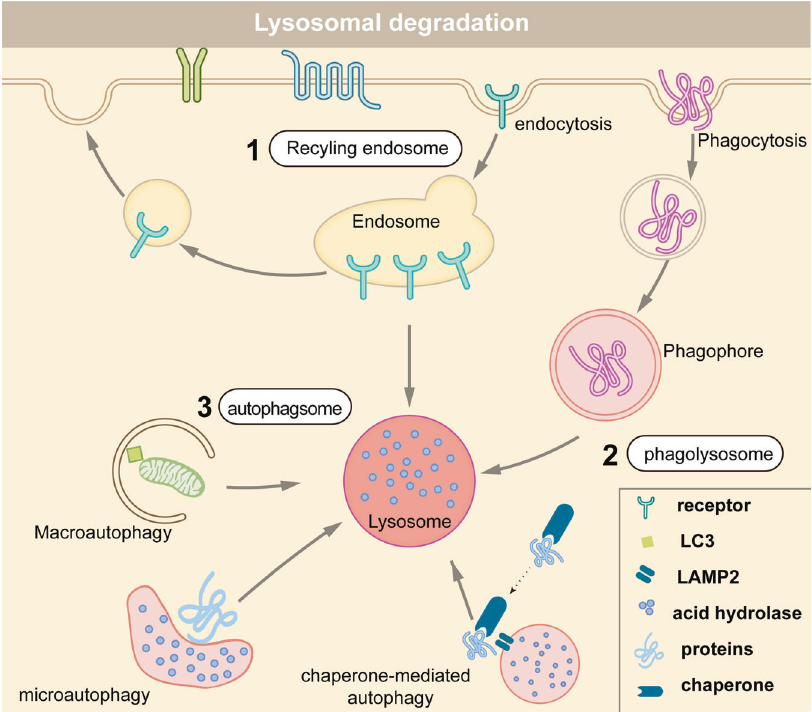
Fig. 2 Protein degradation via three distinct lysosome pathways. (1) Cell surface proteins arrive at endosome after endocytosis. They could be degraded by lysosome, or transported to the plasma membrane or other cellular organelles for recycling. (2) In the phagocytic pathway, cells engulf large extracellular particles, such as invading pathogens and dead cells, and then degrade them by lysosome. (3) Misfolded or aggregated proteins, damaged organelles, and intracellular pathogens, are removed by the autophagy – lysosome pathway. There are three different forms of autophagy: macroautophagy, microautophagy, and chaperone-mediated autophagy